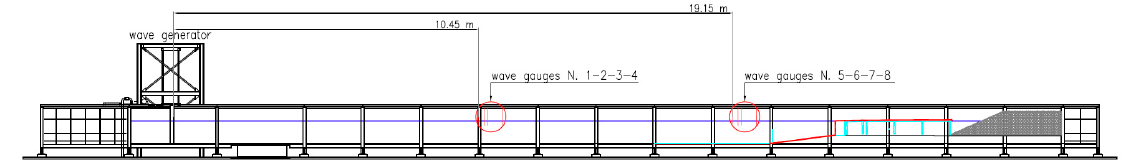
Figure 5. Wave flume and test setup with wave gauges and structure positions.